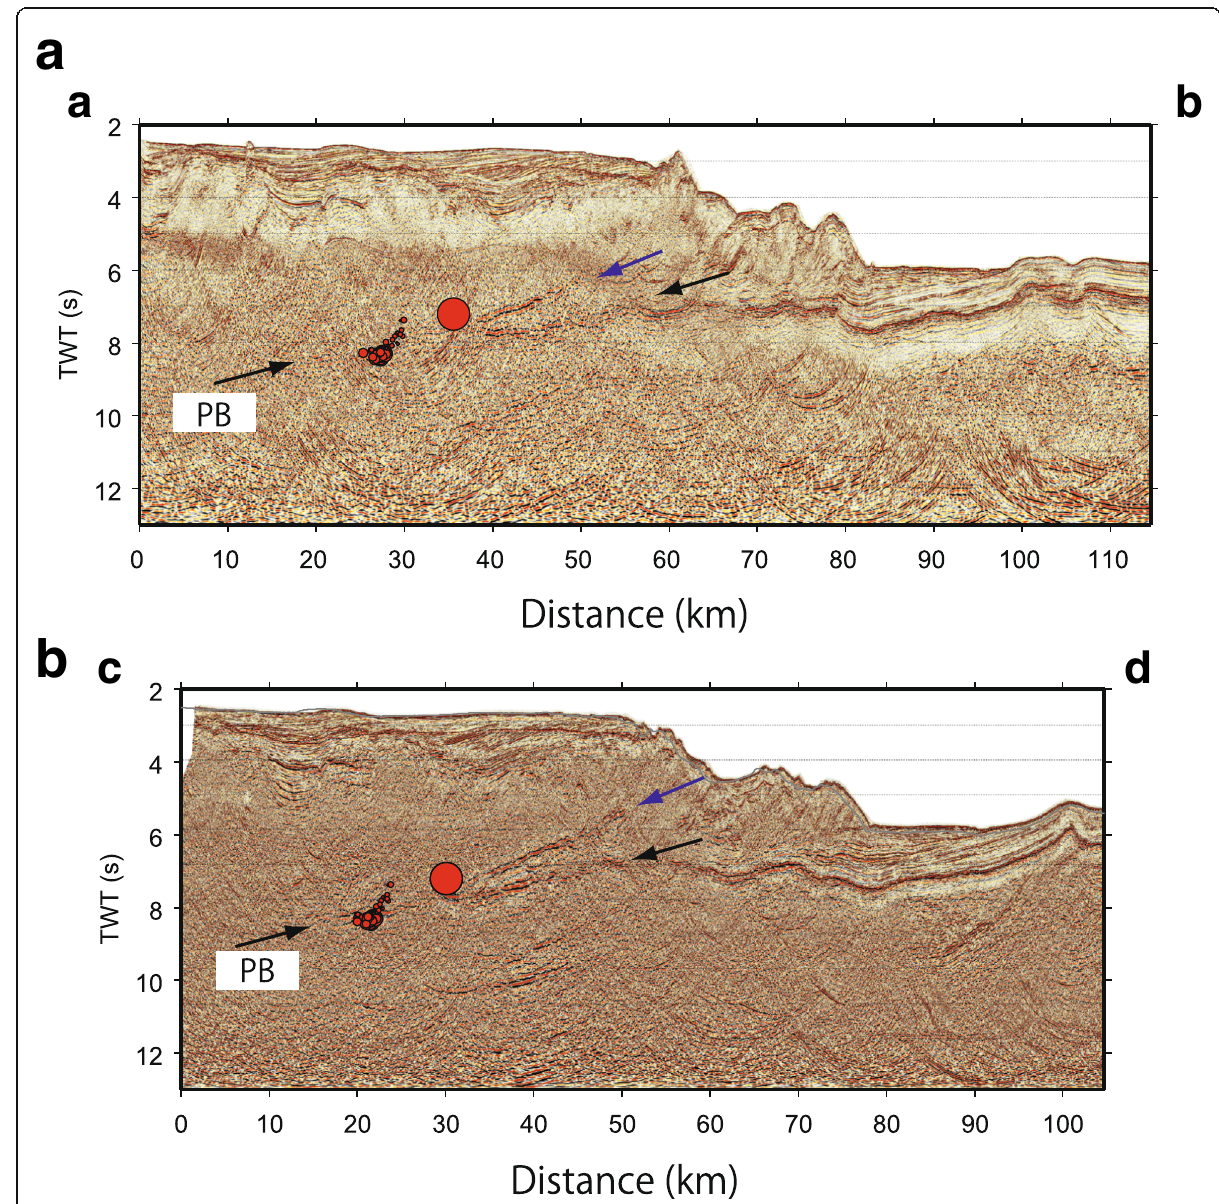
Fig. 5 Hypocenters compared with plate interfaces on sections from a MCS survey. Hypocenter distribution projected on the time-migrated MCS reflection profiles along lines A – B ( a ) and C – D ( b ) shown in Fig. 2a. Arrows represent strong reflections indicative of a plate boundary